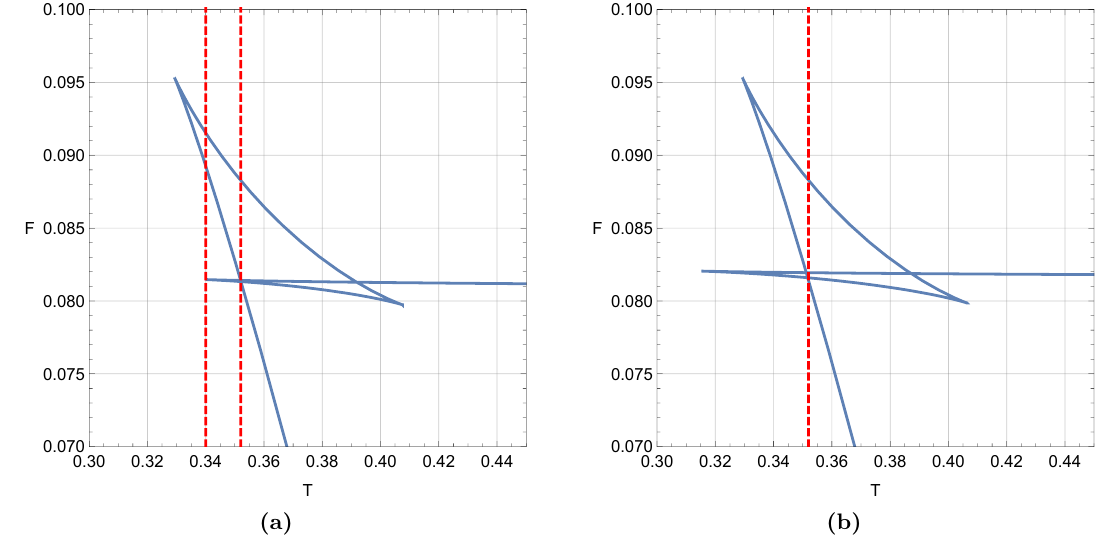
Figure 6 . Helmholtz free energy of the Born-Infeld-de Sitter black hole for (cid:12)xed cavity size ( r c = 0 : 6), pressure ( P = (cid:0) 0 : 0025), and charge ( q = 0 : 1). On the left we have b = 4 : 57565 and on the right b = 4 : 65. The red dashed lines mark the temperature at which phase transitions